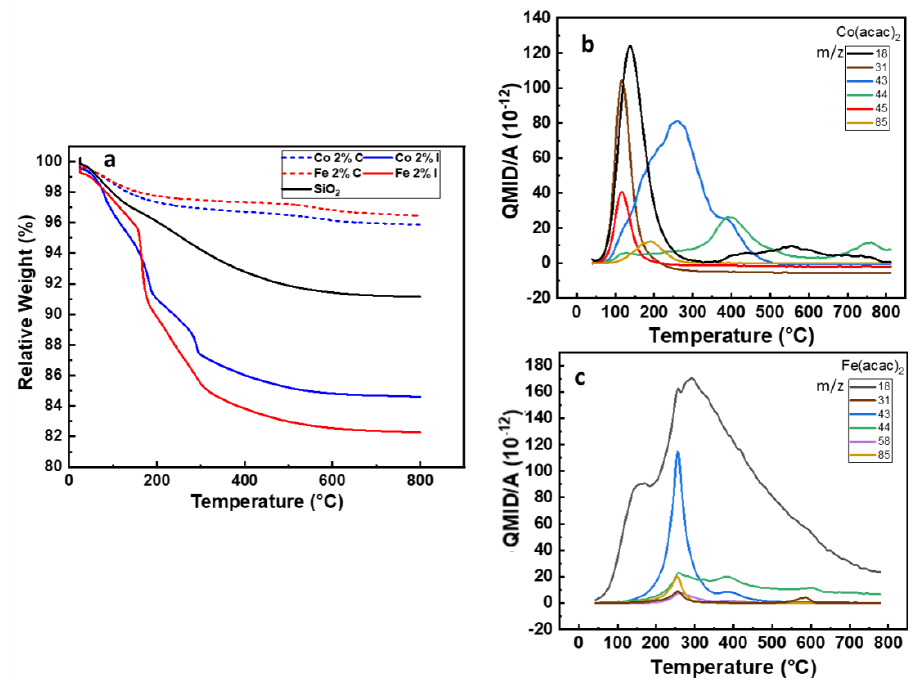
Figure 1. ( a ) TGA under airflow of the SiO 2 before and after impregnation and calcination with Fe(acac) 3 and Co(acac) 2 , ( b , c ) QMID (quasi multiple ion detection) ion current curves under argon for Co 2%I and Fe 2%I,